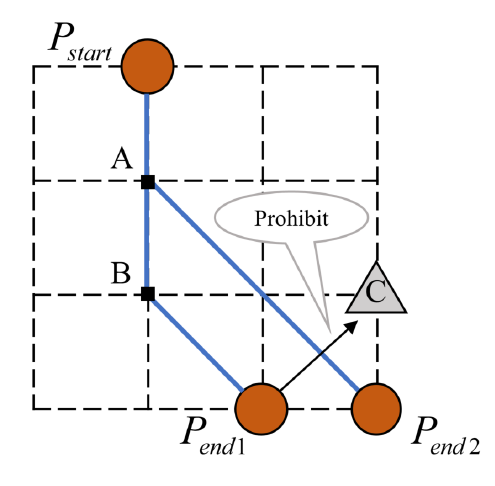
Figure 3. Pipe route overlaps and